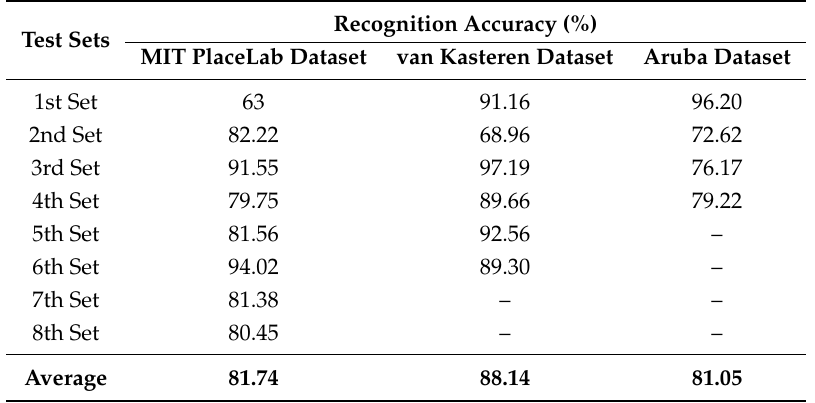
Table 6. Recognition performance in predicting activity based on time and location on each test